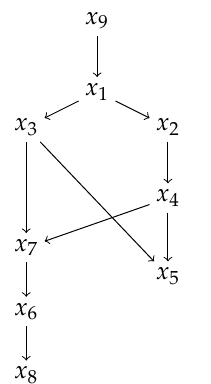
Figure 5. Partial order of projects applying ZAPROS III. Table 12. Rank of the projects applying the proposed MCDM